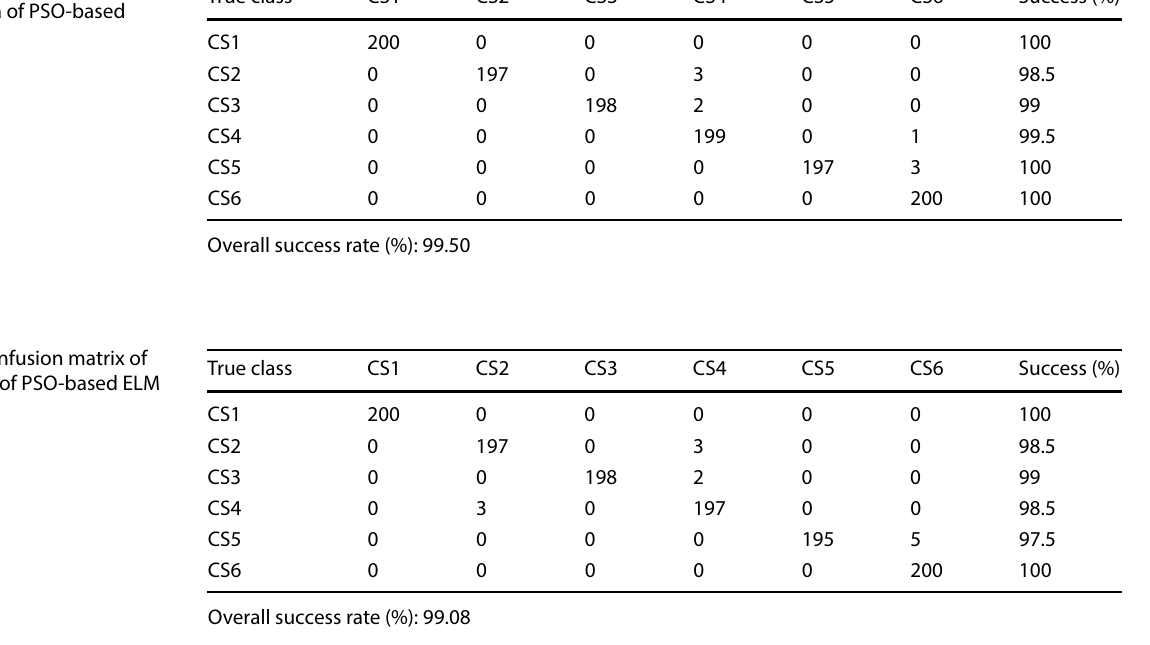
Overall success rate (%):